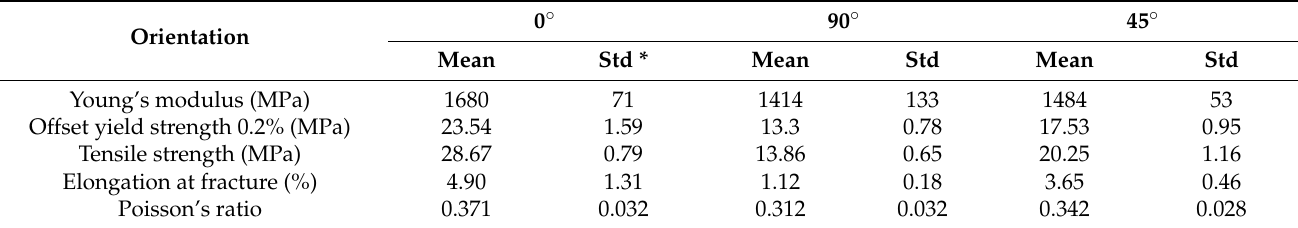
Table 2. Results of tensile